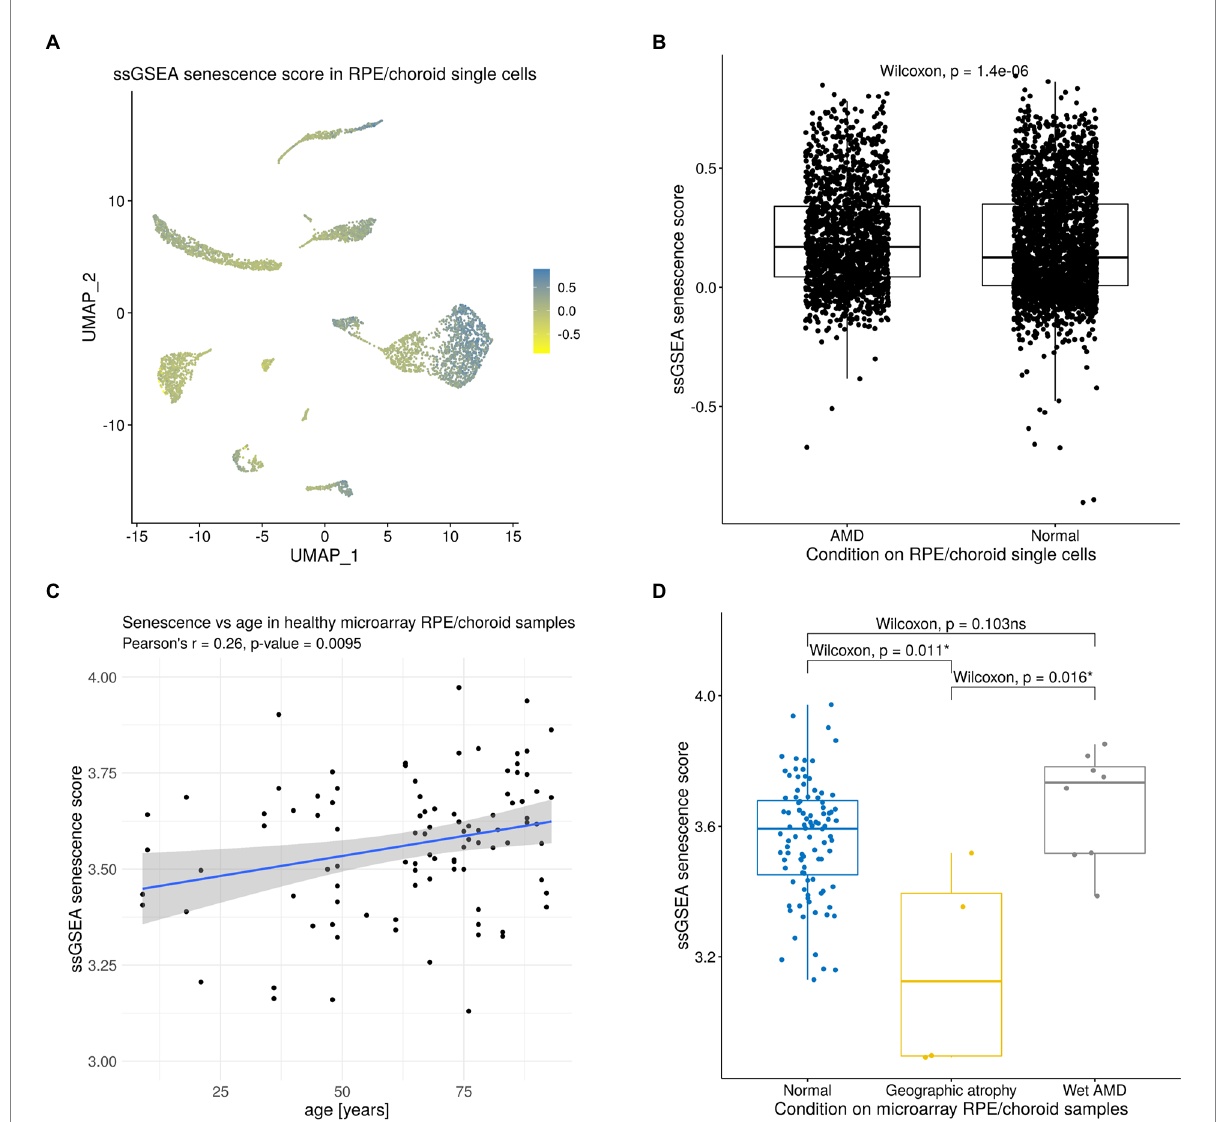
FIGURE 5 Expression of senescence signature genes in RPE/choroid scRNA-seq and microarray data. (A) Dimensionality reduction (UMAP) showing the ssGSEA senescence score of each cell in the scRNA-seq dataset from Voigt et al. (2019). (B) Boxplot showing a slight increase in the senescence score of AMD cells compared to normal cells from Voigt et al. (2019). (C) Positive correlation between senescence scores and age in the non-AMD microarray samples of Newman et al. (2012) (Pearson’s correlation R = 0.26, value of p = 0.0095). (D) Boxplot showing significant and non- significant differences in senescence scores between normal, wet AMD and geographic atrophy RPE/choroid samples from Newman et al.